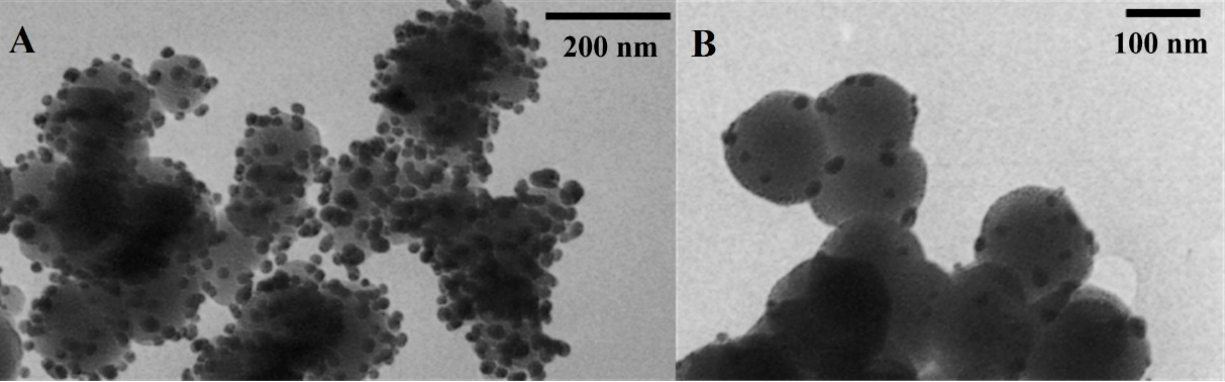
Figure 2. TEM images of amorphous SiO 2 /Ag 0 ( A ) and TiO 2 /Ag 0 ( B ). Table 1. Characteristic of the used nanoforms: SiO 2 /Ag 0 and TiO 2 /Ag 0 . Table 1. Characteristic of the used nanoforms: SiO 2 /Ag 0 and TiO 2 /Ag 0 .